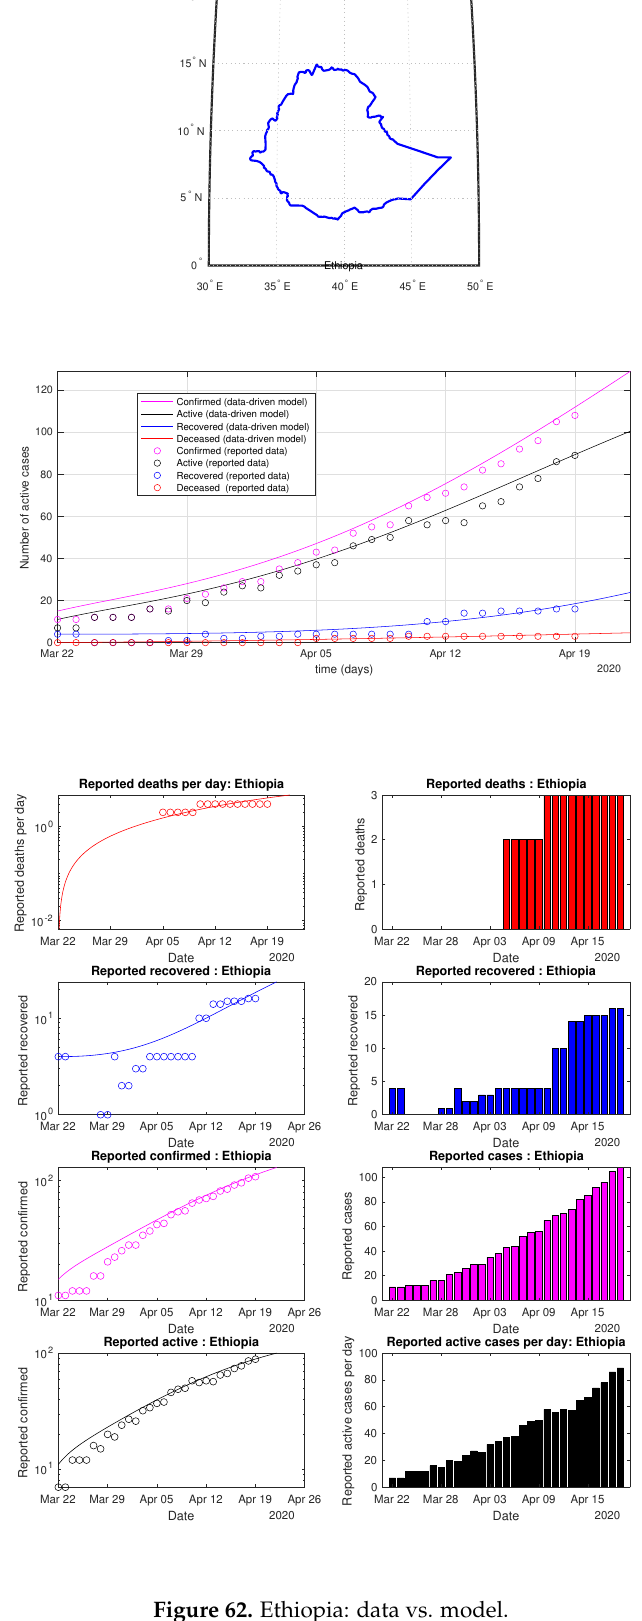
Figure 62. Ethiopia: data vs.